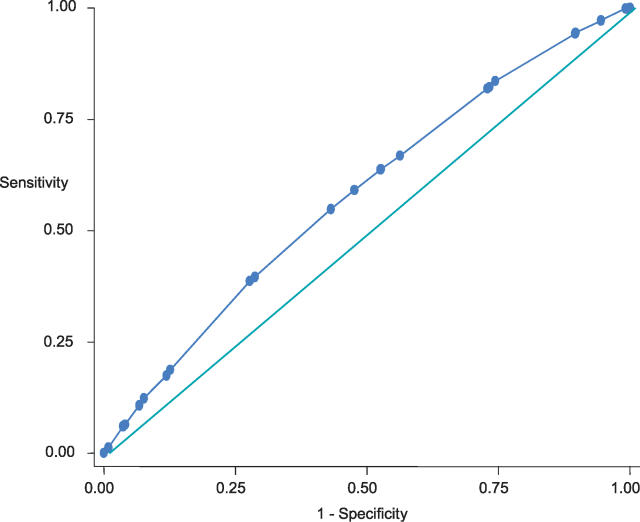
ROC for the Information Provided by the Glu23Lys, Pro12Ala, and rs7903146 Variants after Fitting a Logistic Regression ModelAUC = 0.58.